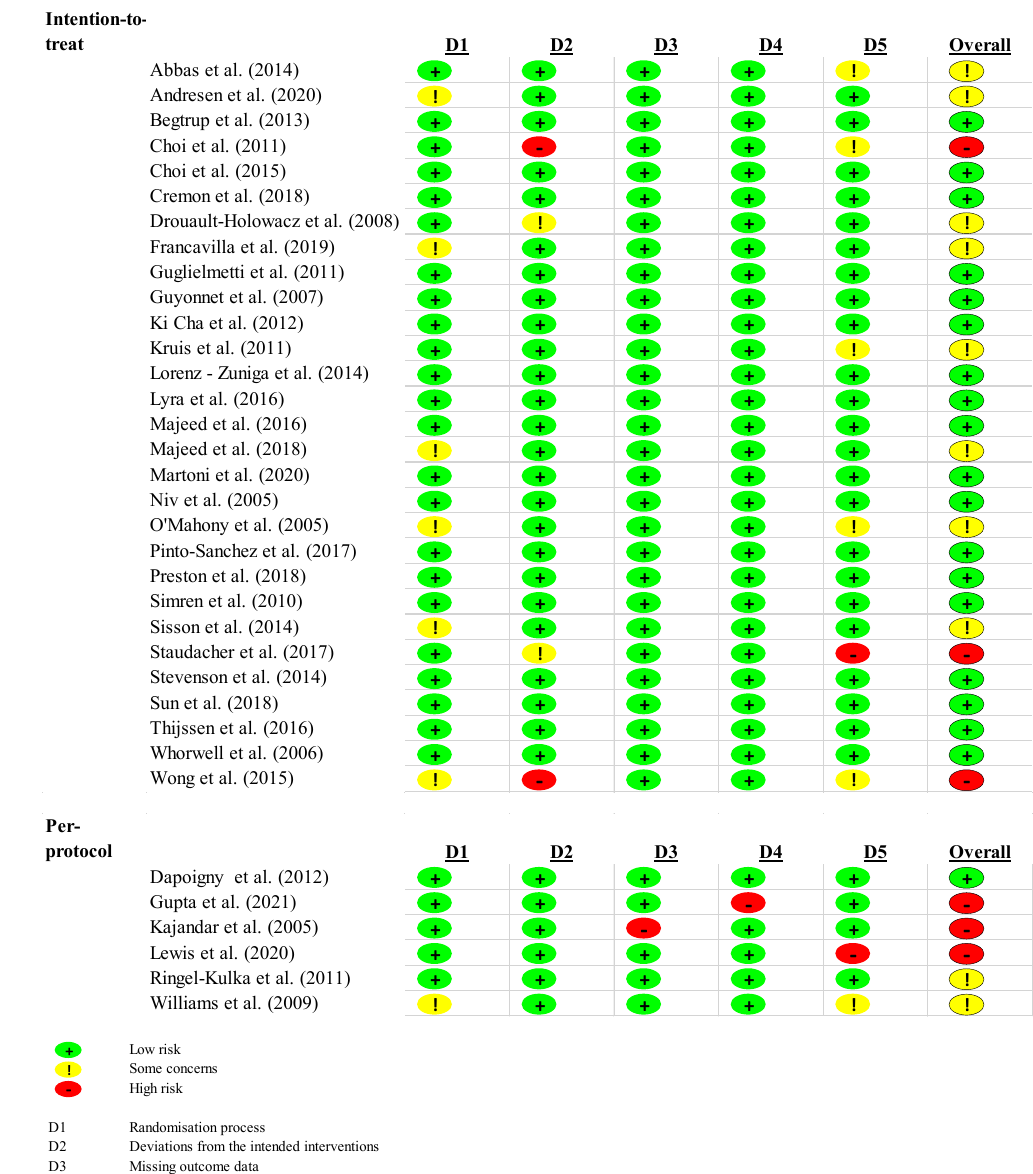
Figure 7 Risk of bias .